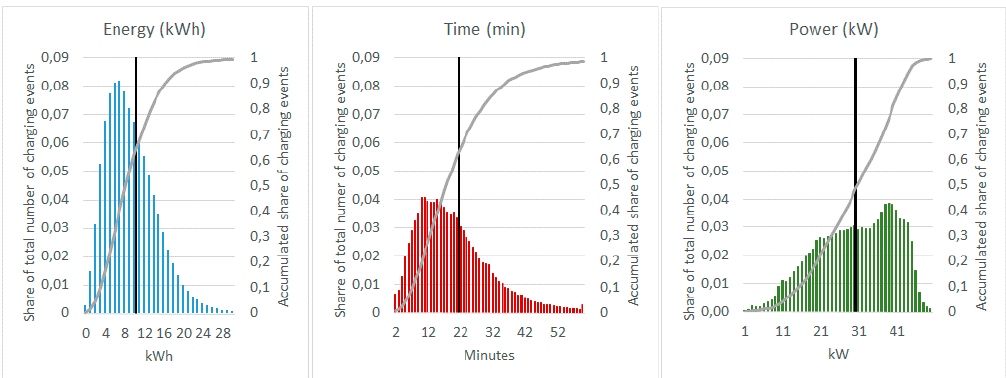
Figure 11. Distribution of share of total charge events per kWh (energy charged) bin ( left ), per minute (time spent charging) bin ( middle ), and per kW (average power) bin ( right ), for 2017. Black line marks the average value rounded to the nearest integer, grey lines show the accumulated share. Source: Dataset 1 and own analysis. Table 2. Charge session average energy (kWh), time (minutes) and power (kW), and corresponding